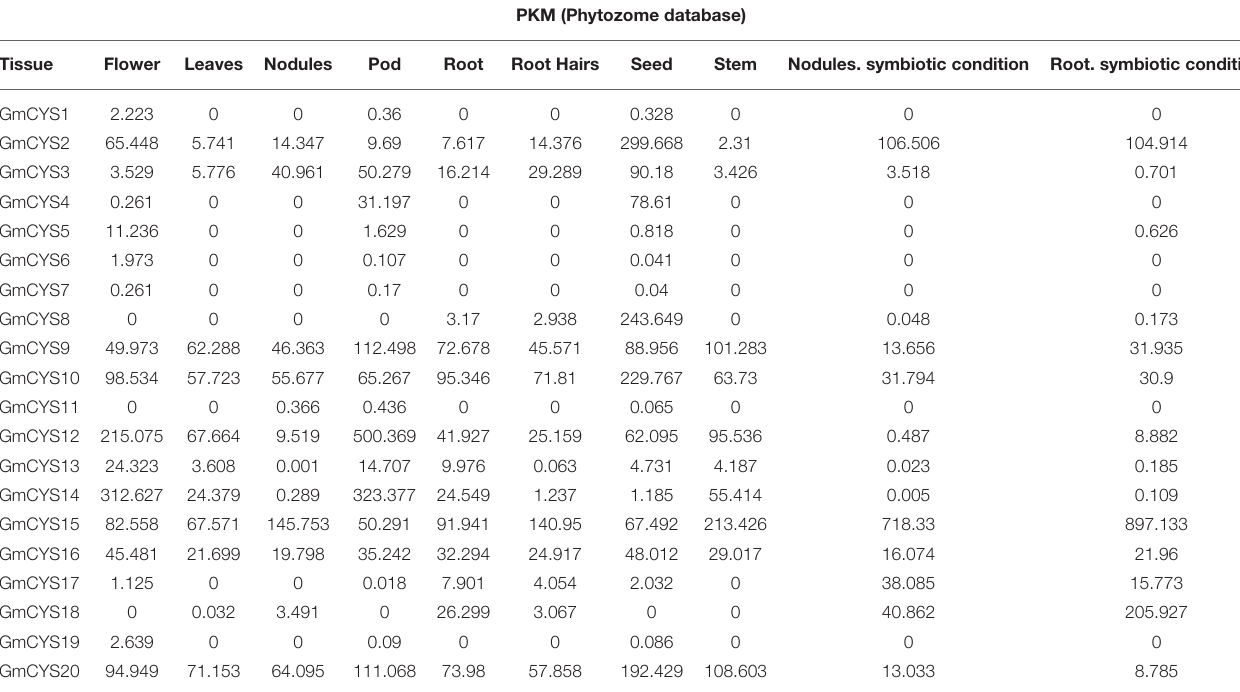
PKM (Phytozome database)